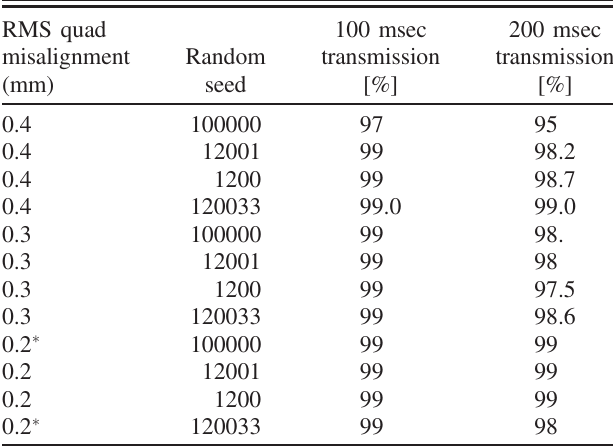
TABLE III. Table of dipole rolls orbit RMS and polarization for two different random seeds assuming no orbit correction scheme applied. Shown are results from two ramp times 200 and 100 msec (calculated using spin tracking in Z GOUBI ).